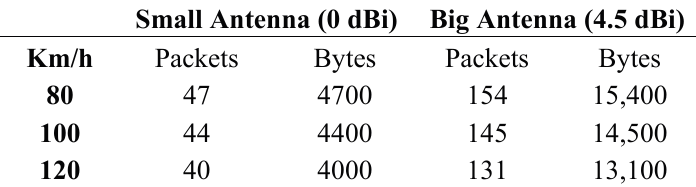
Table 5. Transmission and mobility tests with different antennas (868